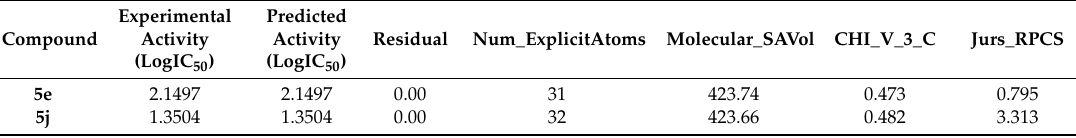
Table 6. External validation of the established QSAR model.